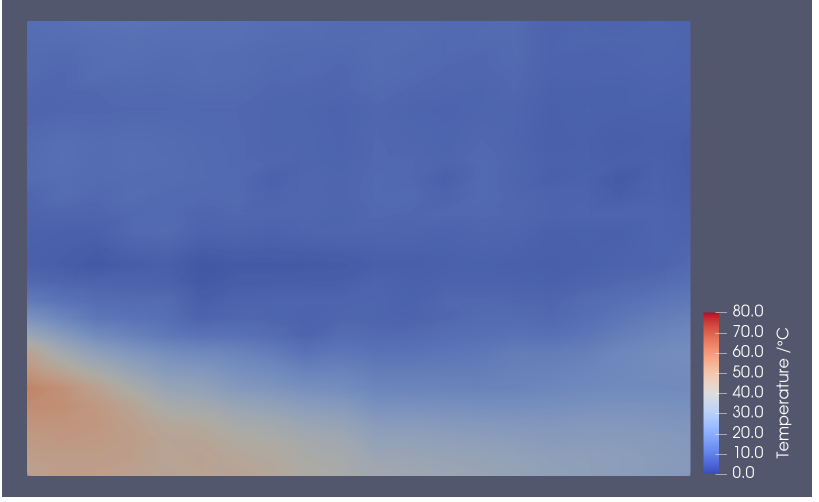
Figure 11. Temperature distribution of mixing layer of heating/cooling airflow.